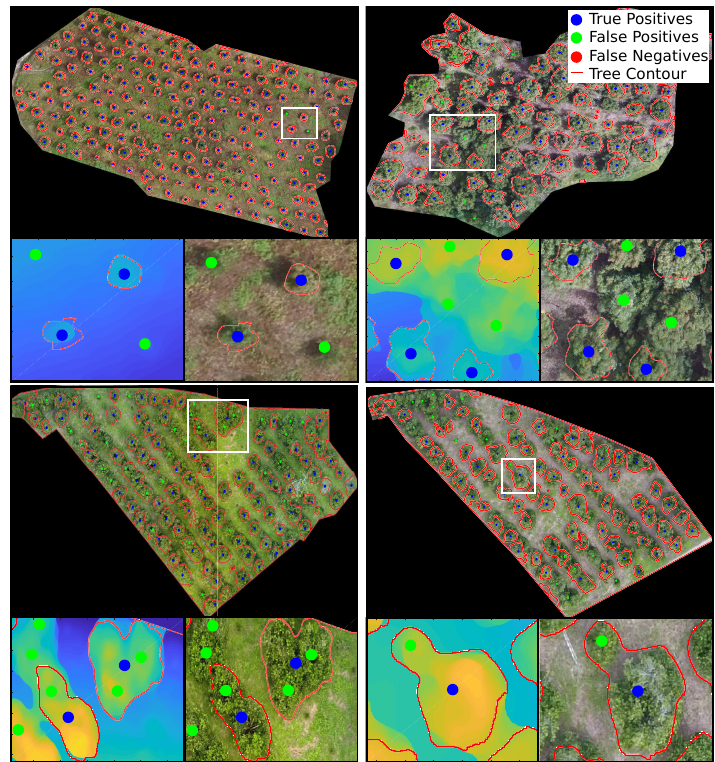
Figure 5. Results of Farm 1 and 3 data set using SEMAX* approach, where blue, red and green dots represent true positives, false negatives and false positives, respectively.